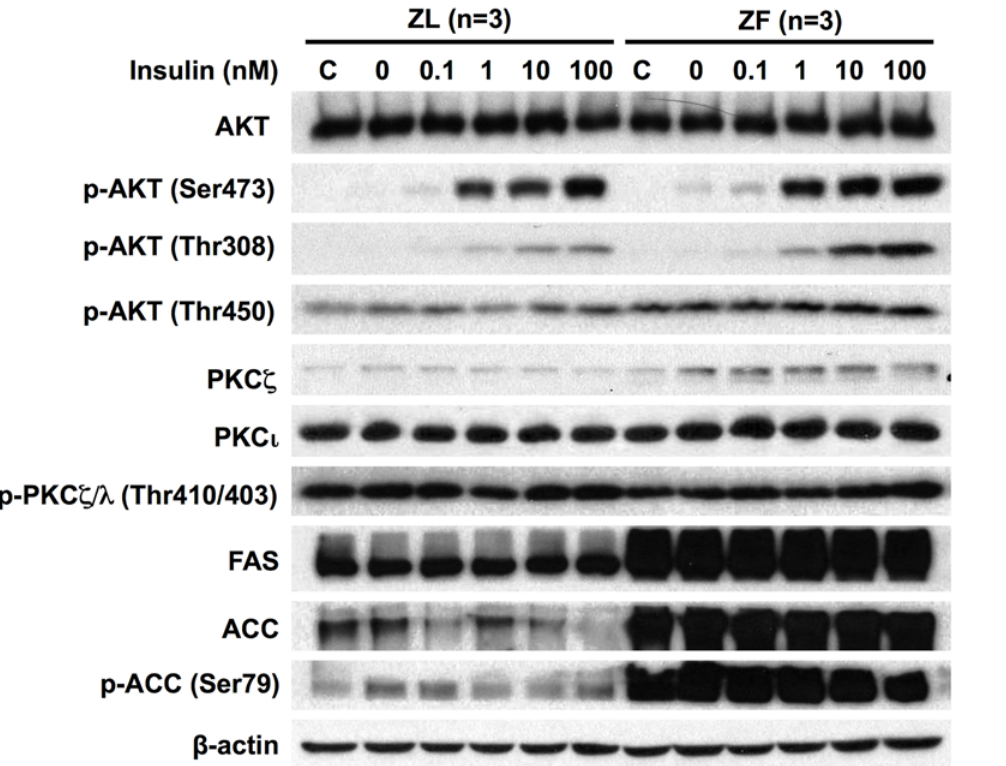
Fig 2. Acute insulin treatment did not alter protein levels of total and phospho-aPKCs in primary hepatocytes from ZL and ZF rats. The primary hepatocytes from ZL and ZF rats (chow diet, 8 weeks) were pre-treated as described in the Materials and Methods for overnight, and then incubated in fresh medium A with increasing concentrations of insulin (0nM to 100nM) for 15 min. The hepatocyte group remained in pre-treatment medium was indicated by “ C ” . Immunoblot analysis with antibodies against the indicated proteins was performed. The figure shows the representative result of three parallel experiments obtained from three sets of primary hepatocytes independently isolated from ZL and ZF rats fed chow diet ad libitum.